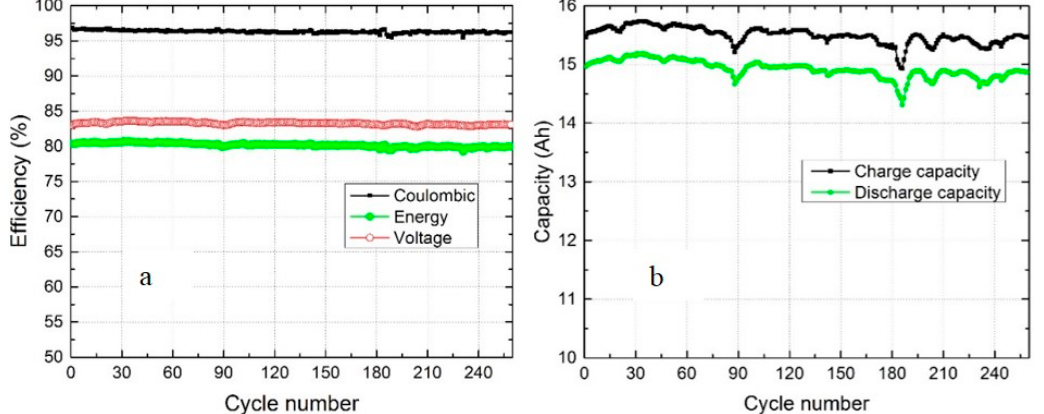
Figure 3. Performance of an in-house developed 1 kW stack tested with auto-rebalancing of electrolyte ( a ) coulombic efficiency, energy efficiency and voltage efficiency and ( b ) charge and discharge capacity (in Ah).